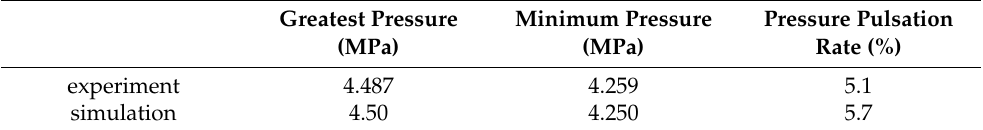
Table 5. Comparative analysis of the fluid pressure fluctuation value and pressure fluctuation rate.